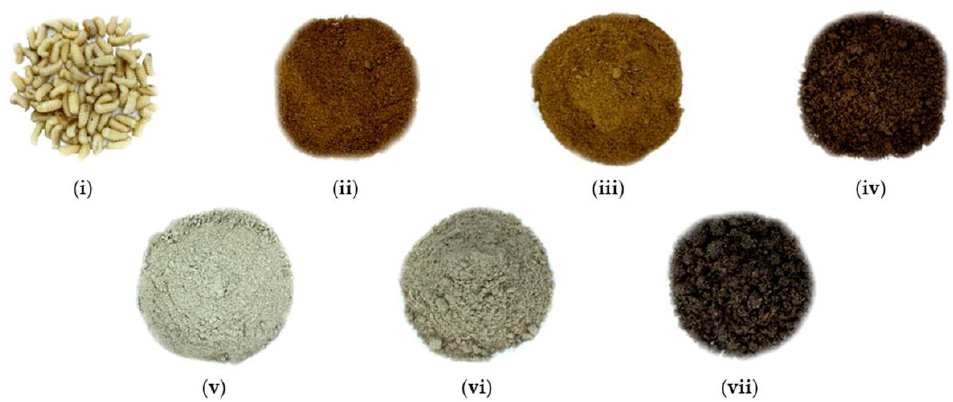
Figure 2. Sample groups of drone pupae ( Apis mellifera L.) powder processed under different con-